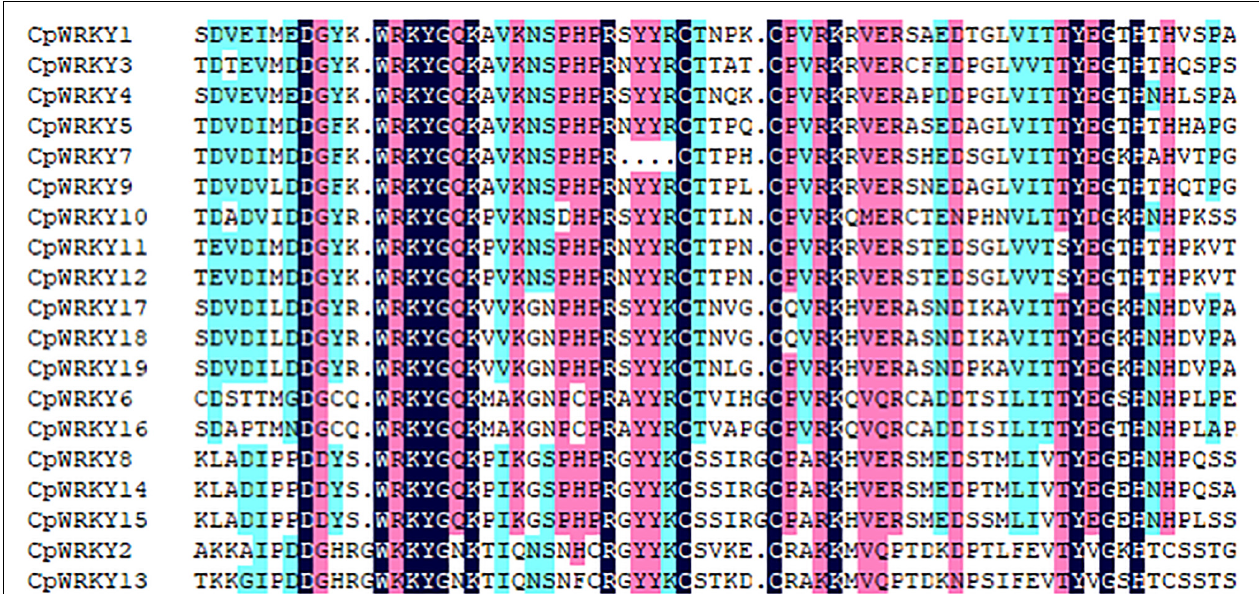
FIGURE 2 | Alignment of WRKY conserved domain sequences in Calohypnum plumiforme. The dark blue background represents conserved amino acid residues (100%), while the pink background represents the conserved amino acid residues (75%). Two red boxes represent the conserved heptapeptide domain and the variable zinc finger